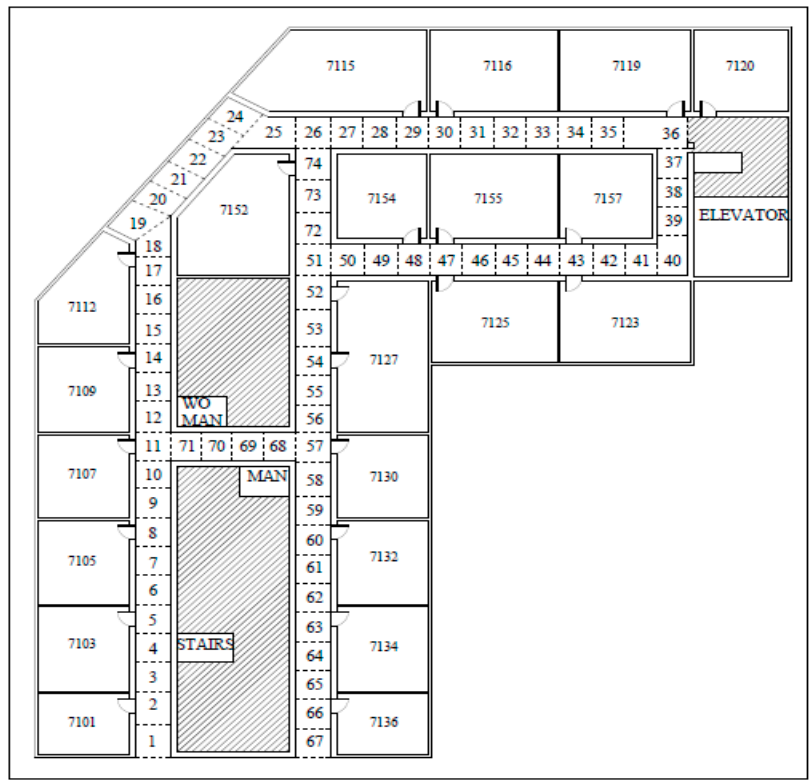
Figure 7 . Indoor environment (radio map) for data collection divided into 74 reference points (2 m × 2 m each) .